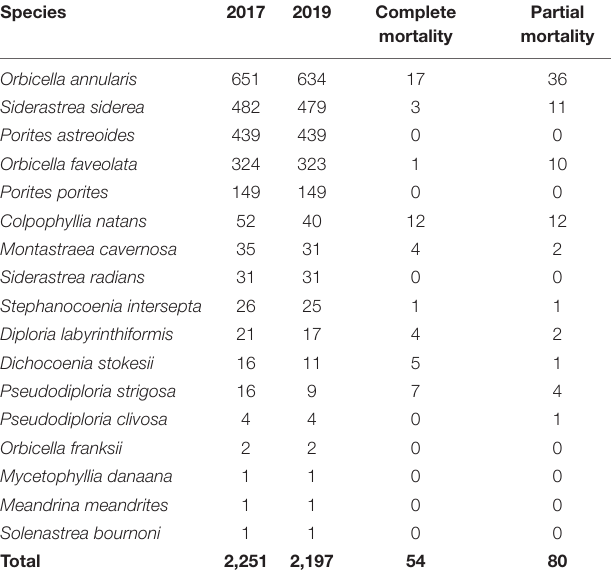
TABLE 2 | Proportion of colonies experiencing partial or complete mortality, and overall disease prevalence across all six plots in 2019. Species Percent complete Percent partial